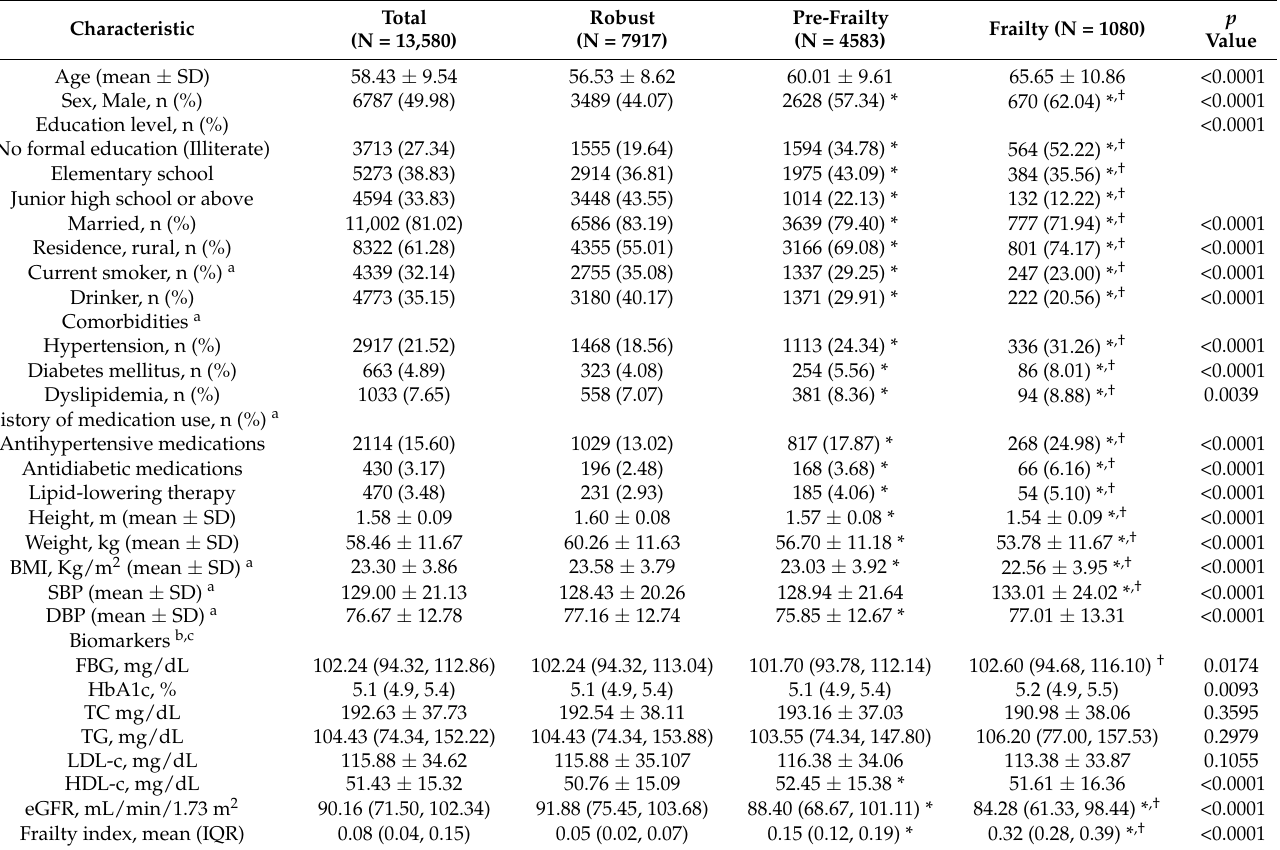
Table 1. Baseline characteristics of study population by frailty status in longitudinal